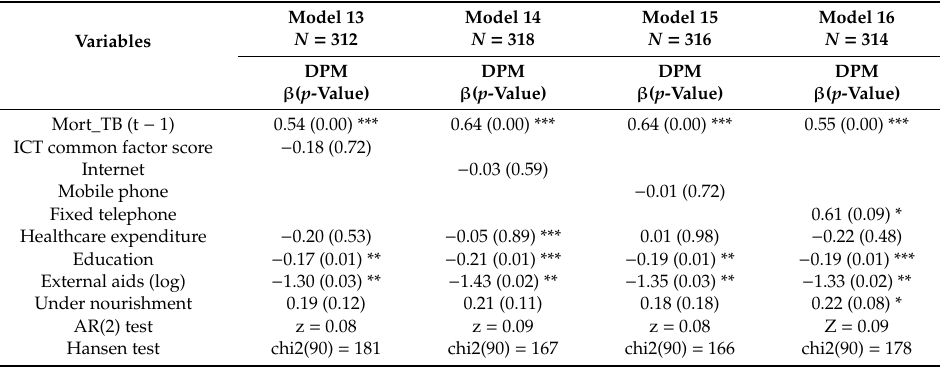
Table 5. Estimation results: ICT and tuberculosis mortality